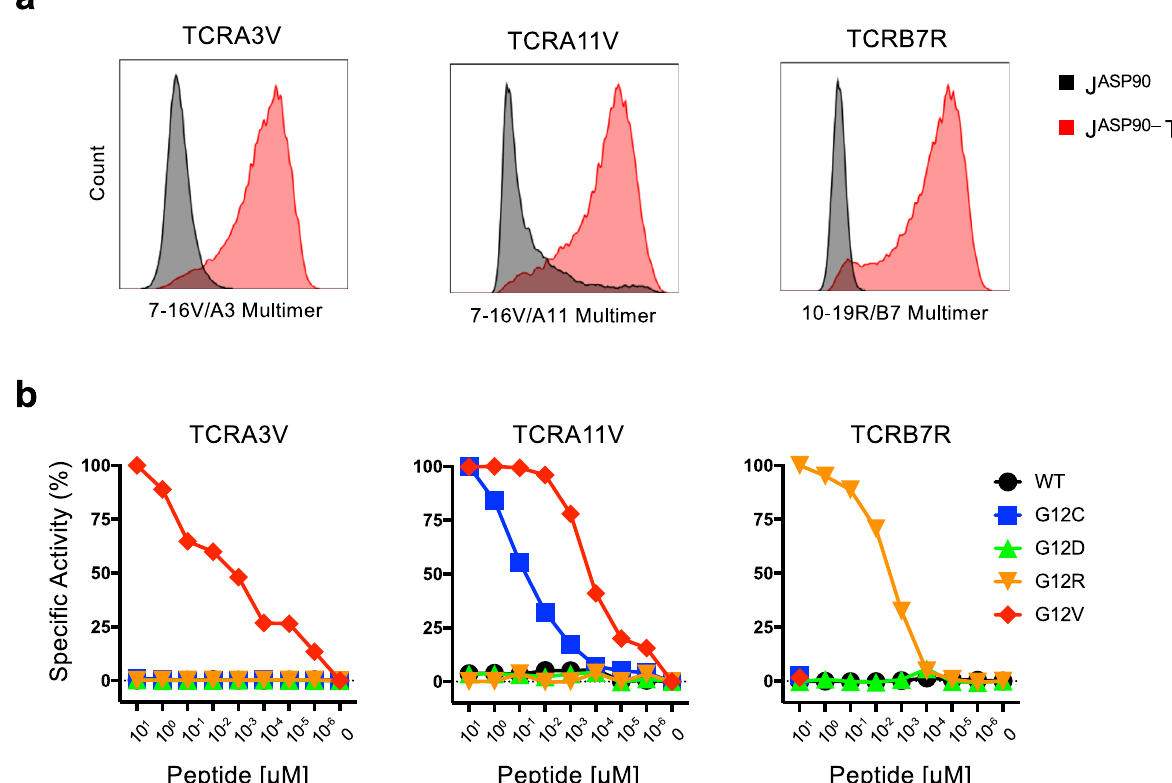
Fig. 3 Validation and functional characterization of mKRAS-speci fi c TCRs. a FACS histogram plots demonstrating p-HLA multimer staining following lentiviral engineering of J ASP90 reporter cells with TCRA3V, TCRA11V, and TCRB7R constructs (red) vs TCR αβ null controls (black). b J ASP90 reporter assay to evaluate antigen recognition. J ASP90 reporter cells expressing TCRA3V, TCRA11V, or TCRB7R were cocultured with HLA-matched monoallelic K562 cell lines pulsed with titrated concentrations of WT KRAS or mKRAS peptides. TCR signaling is indicated by eGFP expression upon NFAT activation. TCR avidity was determined as the mean peptide concentration required to achieve 50% NFAT activation of TCR-engineered J ASP90 reporter cells. Speci fi c Activity (%) = (%GFP Test – %GFP Min ) / (%GFP Max – %GFP Min ) x 100. Representative experiments of three independent evaluations are shown. Source data are provided as a Source Data fi